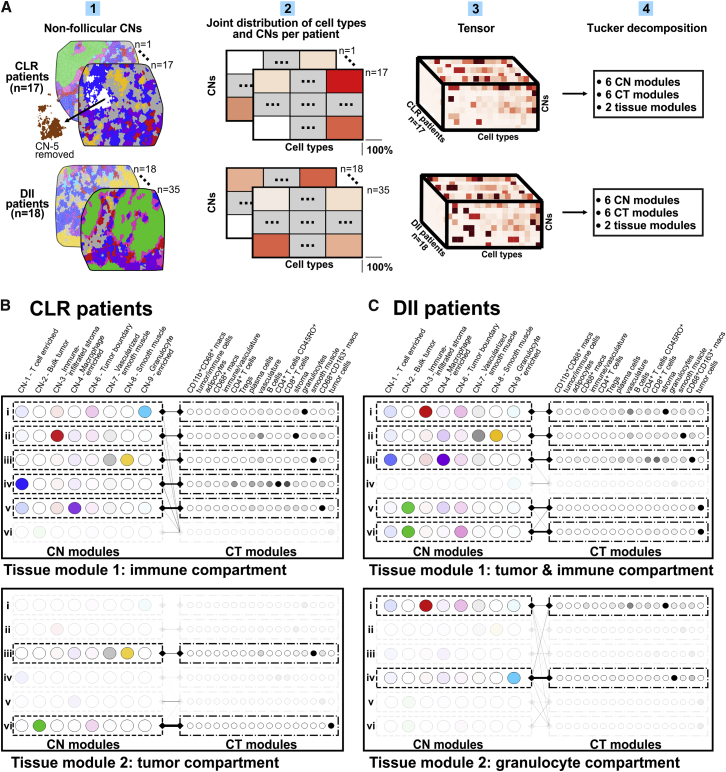
Tensor Decomposition Suggests Differences in Organization of the iTME(A) Schematic of the tensor decomposition analysis.(B) Decomposition results for CLR patients. Tissue modules (interacting pairs of CN modules and CT modules) correspond to an “immune compartment” (top) and a “tumor compartment” (bottom).(C) Decomposition results for DII patients. Tissue modules correspond to an “immune and tumor compartment” (top) and a “granulocyte compartment” (bottom).See also Figure S6C and Data S7.